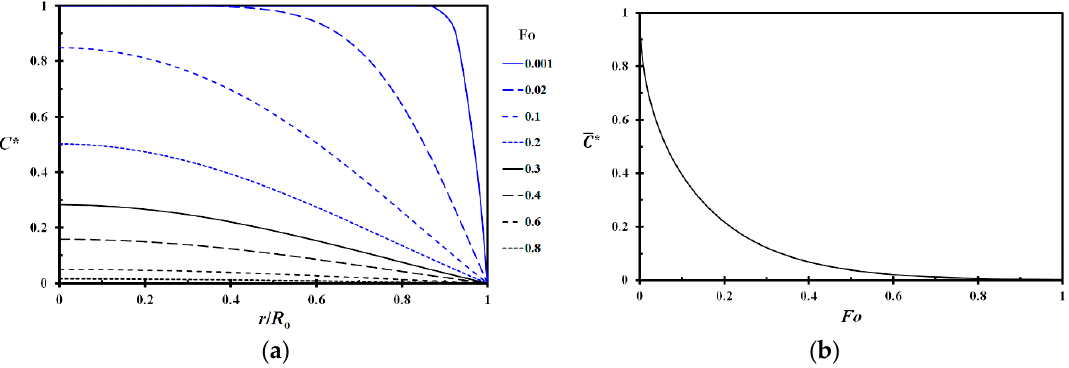
Figure A3. Dimensionless concentration (Equation (A10)) as a function of the relative radius and Fourier number ( a ) and dimensionless average concentration as a function of the Fourier number ( b ).